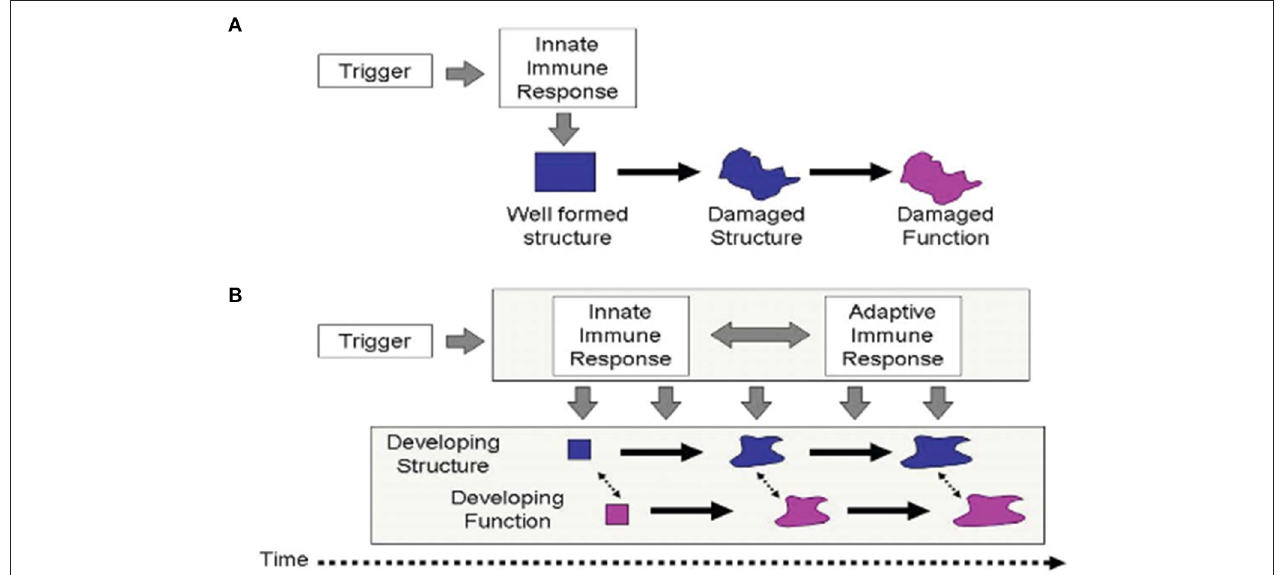
FIGURE 2 | The traditional scenario of perinatal brain injury (A) postulates that a single and an abrupt insult damages existing structure, expressed as altered function. This process often occurs from immune intolerance introducing an inflammatory process. Malaeb and Dammann (40) proposes an alternative view (B) , which postulates that after an initial trigger has occurred, an ongoing interaction between innate and adaptive immune processes adversely affects the development of structure and function over an extended period of time through infectious or non-infectious inflammatory mechanisms affecting the developing